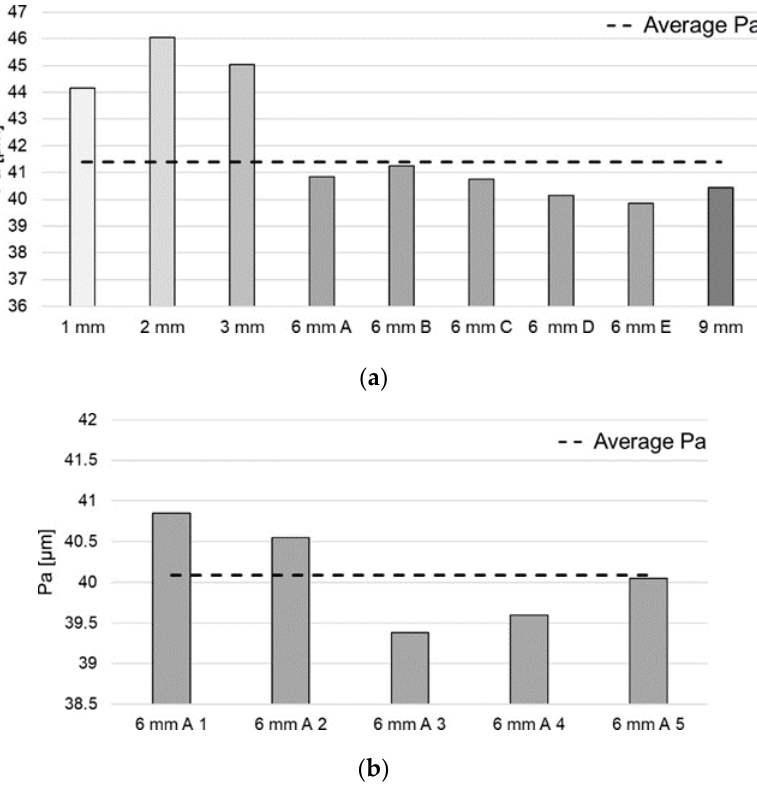
Figure 12. Average Pa -values. ( a ) Average Pa -values for all investigated channels showing a distinct grouping of channel sizes based on similar Pa -values. ( b ) Pa -values obtained from the repeated X-ray CT scans of channel 6 mm A.